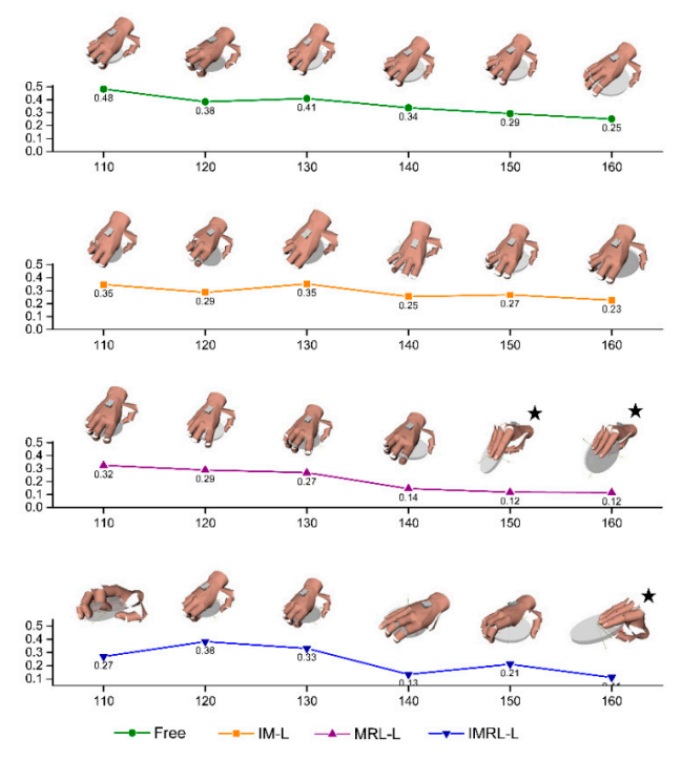
Figure 8. Maximum grasp quality with the simulator. The grasp gesture at each point is the optimal gesture out of 10 gestures. The asterisk represents an exceptive gesture that is not a precision disk